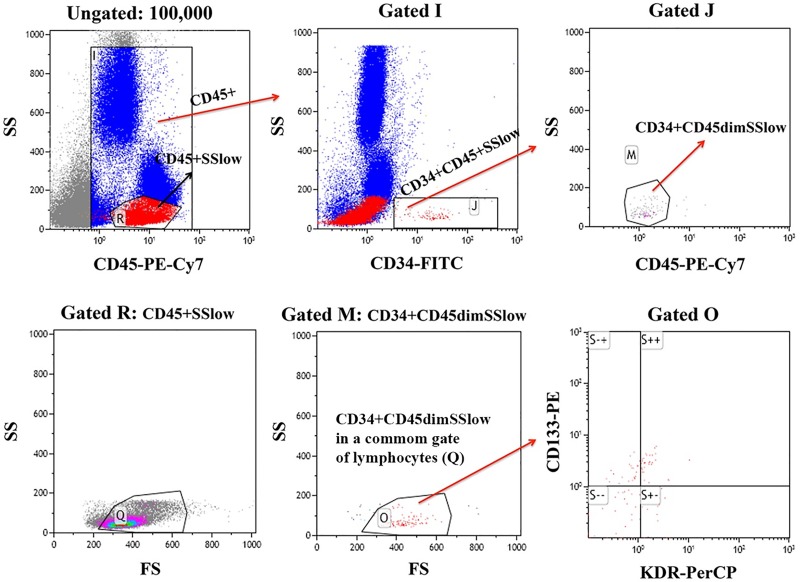
Gating strategy based on ISHAGE guidelines.Total CD45+ cells were gated, followed by Side Scatter (SS) vs CD34-FITC. The CD34+CD45+SSlow subset was selected (Gate J). A second SS vs CD45-PE-Cy7 gating was performed to select CD45dim cells (Gate M), and confirmed by a low Forward Scatter (R- a shared lymphocyte gate; Gate O). Analyzing CD34-FITC vs CD45-PE-Cy7 cells, a subset should be coincident with gate Q (lymphocyte). Expression of CD133 and/or KDR was assessed on CD34+CD45dimSSlow cells (gated O).